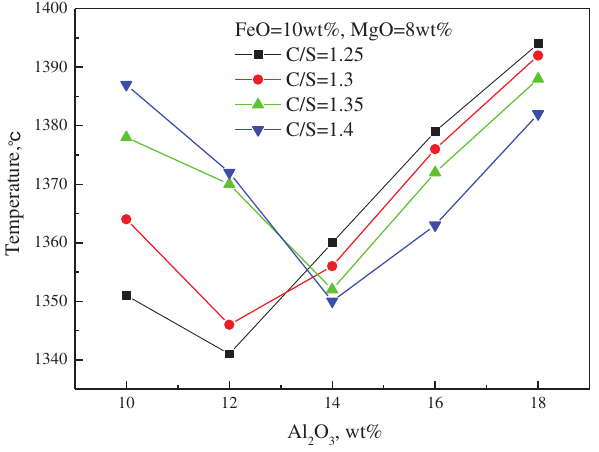
Figure 8: Effect of the basicity on the T LQ of CaO – SiO 2 – Al 2 O 3 – MgO – FeO system at 8 wt% MgO and 10 wt%